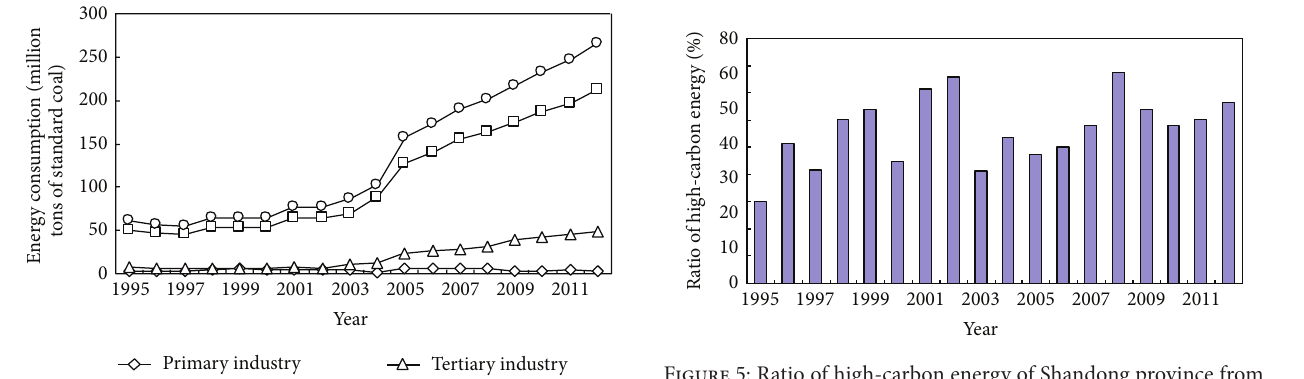
Figure 5: Ratio of high-carbon energy of Shandong province from